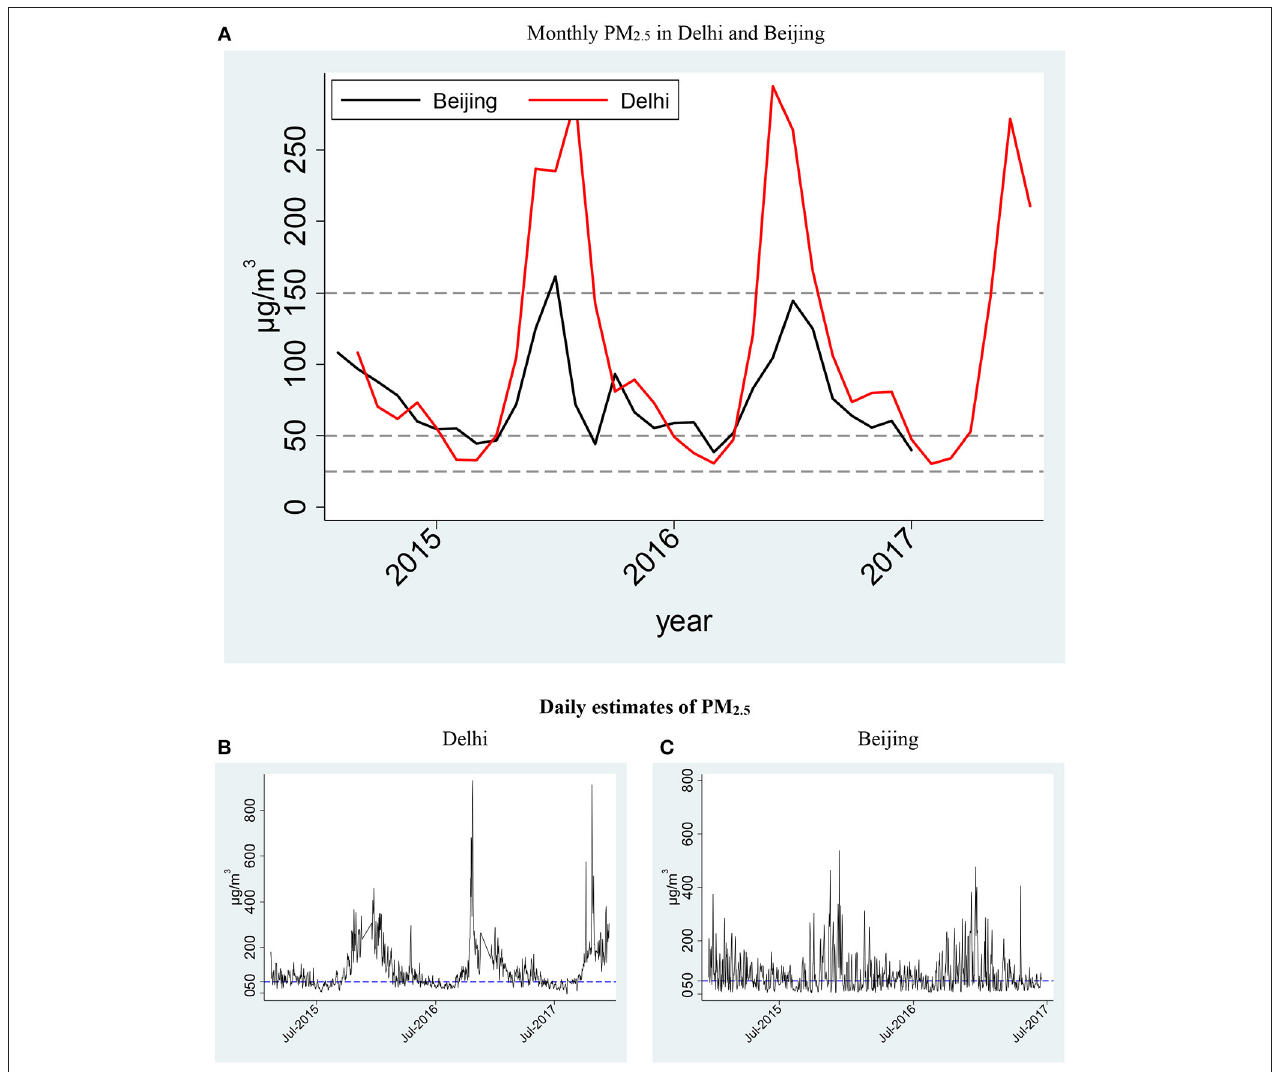
FIGURE 2 | (A) Monthly concentration of PM 2.5 monitored in American Embassy Premise in Delhi (B) and Beijing (C)